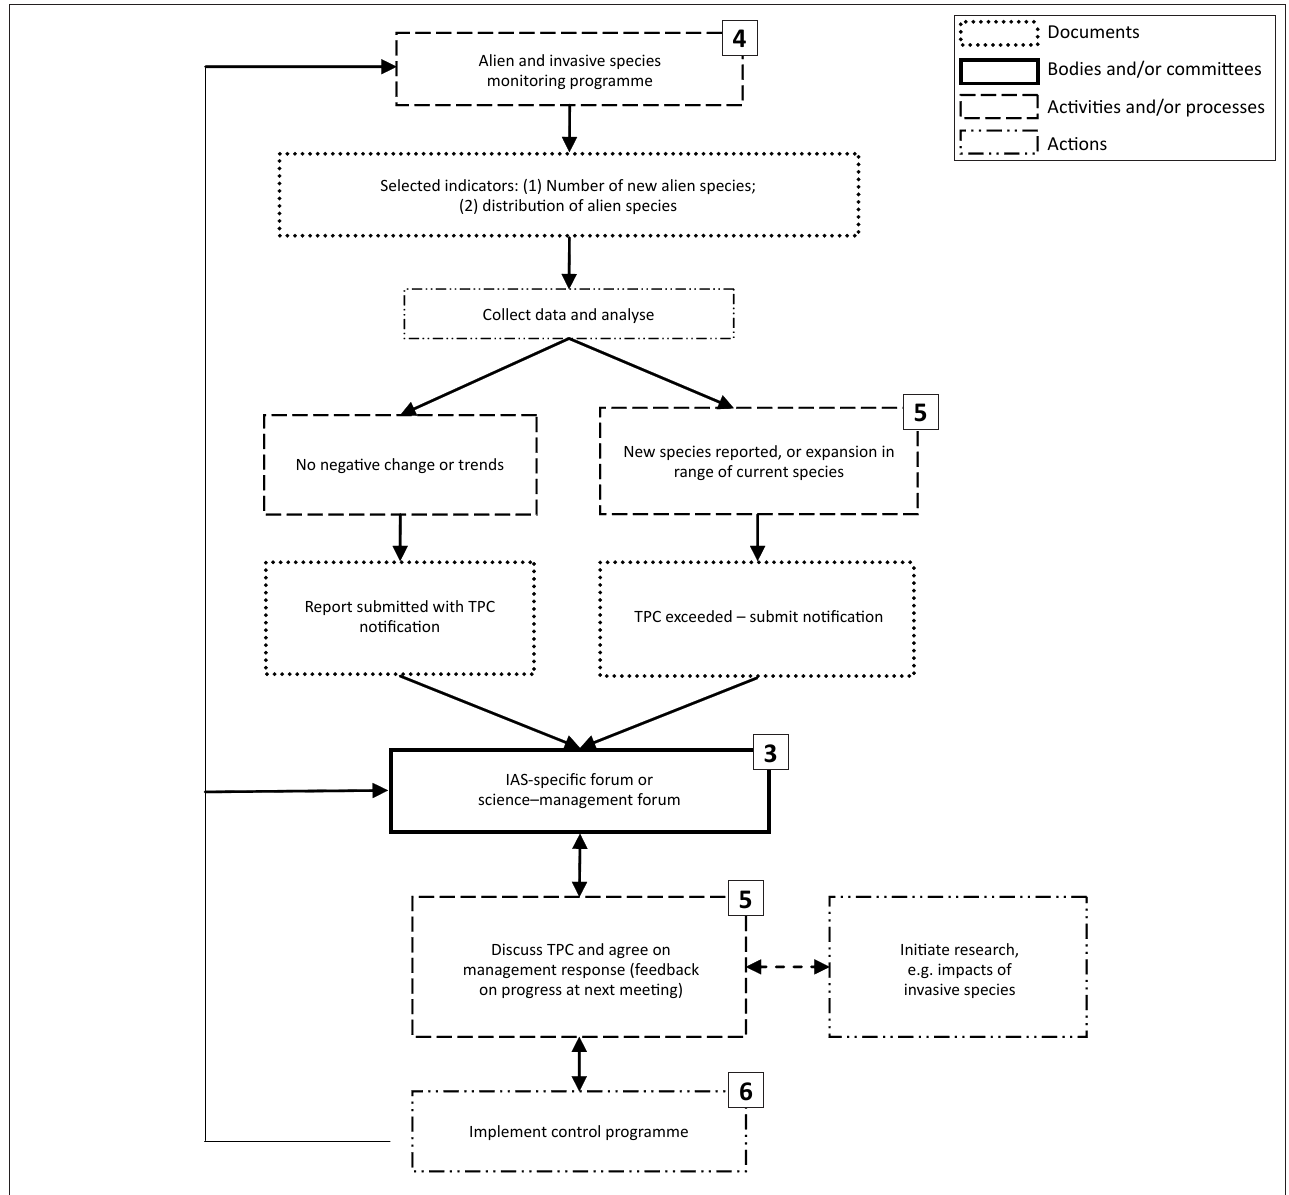
FIGURE 3 : A schematic figure of the monitoring process (as a more detailed subset of Figure 2). The aim of the monitoring programme is to detect the change and trends in the number and distribution of alien species in a predefined area. Despite a number of barriers (see Jacobson et al . 2006) that will require ongoing assessment and reflection, the framework provides one approach for fully implementing AM. In future, options should be explored for streamlining and simplifying the array of documents, bodies and/or committees and processes that constitute invasive alien species management (as reflected in the supplementary material, Figure